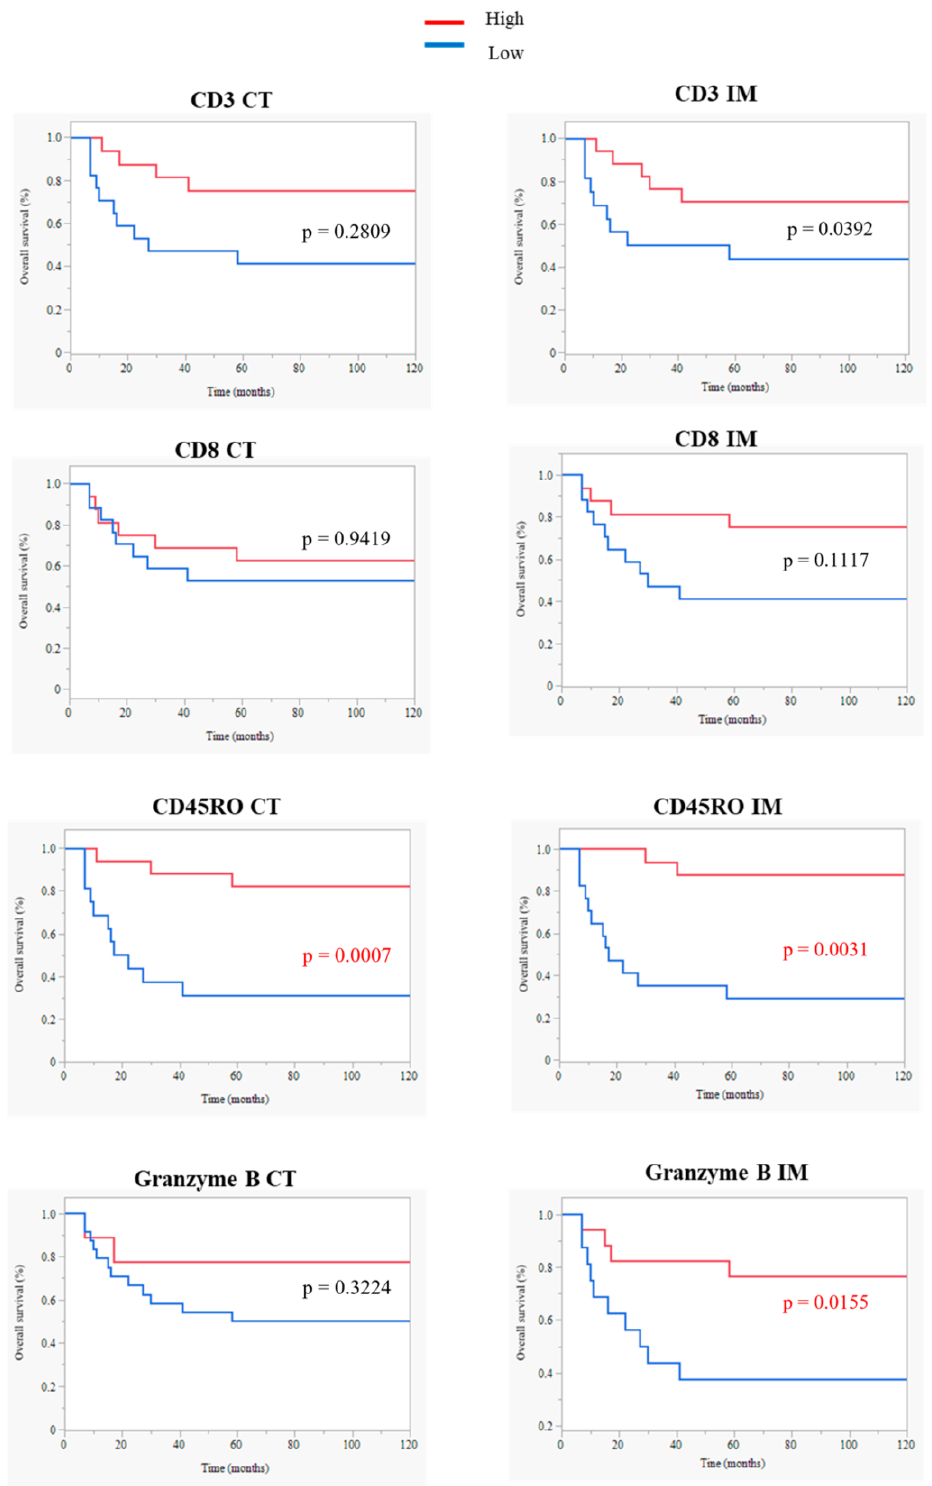
Figure 4. Kaplan–Meier curves of overall survival according to TIL density in OSCC tissue. Each graph showed the overall survival (OS) of OSCC patients with high (red line) and low (blue line) numbers of CD3 + , CD8 + , CD45RO + , and Granzyme B + /TILs in the CT (left panels) or IM (right panels) areas. Patients with CD45RO + /TILs High CT ( p = 0.0007) and IM ( p = 0.0031) and Granzyme B + /TILs High IM ( p = 0.0155) had a significantly improved OS, as indicated by Kaplan–Meier curves. A log-rank test was utilized to determine differences. Statistically significant difference at p < 0.05 (red values).